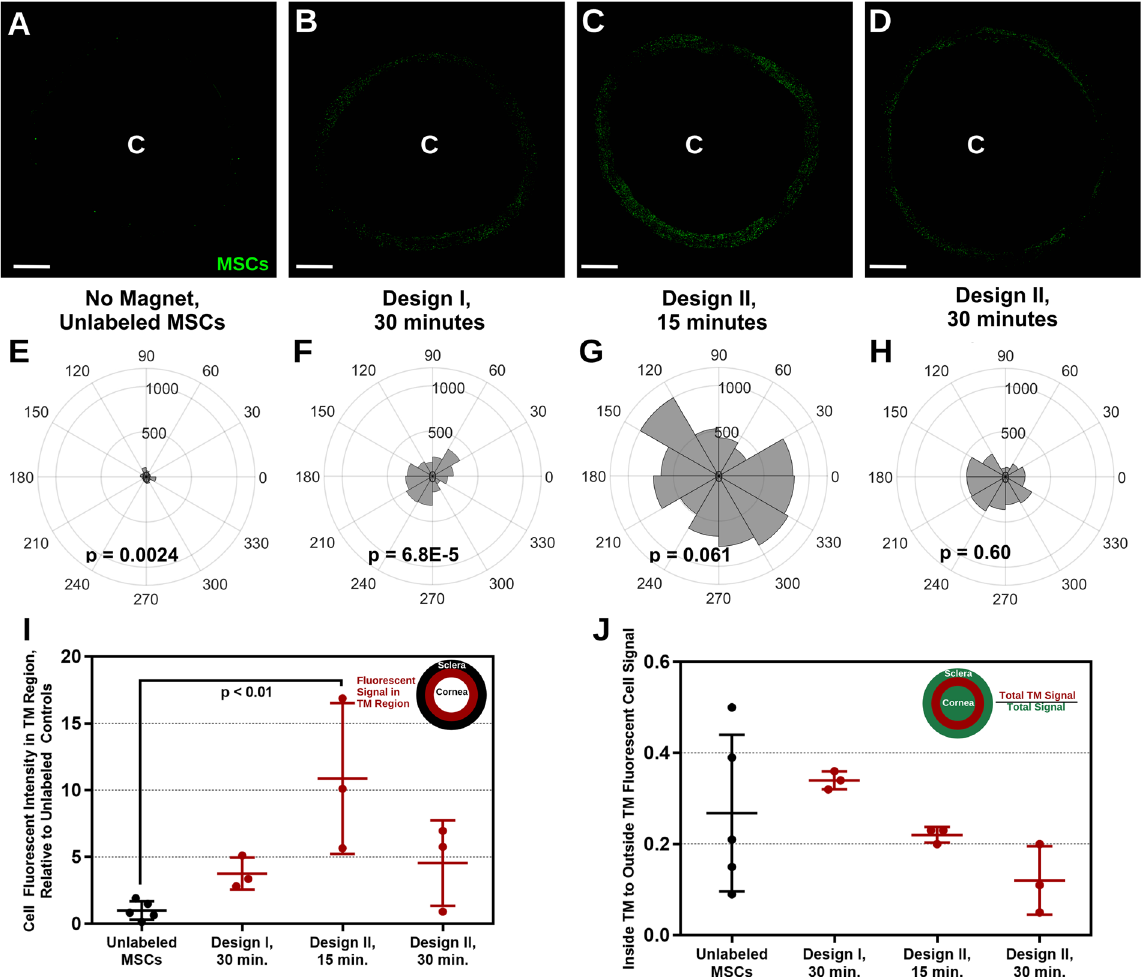
Figure 4. 360° Delivery of PBNC-MSCs Using Ring Magnets. (A–D) PBNC-MSCs were injected into eyes with two types of ring magnets placed around the circumference for different durations. Representative en face micrographs are shown. “C” denotes the approximate center of the cornea. Note that the image has been masked so that only signal from the putative TM region is shown (see Methods). Scale bars denote 2 mm. (E–H) The polar histograms illustrate the total fluorescence intensity within the TM region (plotted on the radial coordinate, in arbitrary units) for 30° sectors around the eye. P-values were calculated using Rayleigh’s test to assess uniform circumferential delivery (p < 0.05 denotes non-uniform delivery). (A,E) no magnet (n = 5 eyes), (B,F) Magnet Design I for 30 minutes (n = 3 eyes), (C,G) Magnet Design II for 15 minutes (n = 3 eyes), and (D , H) Magnet Design II for 30 minutes (n = 3 eyes) experiments are shown. (I) Quantification of cell signal in the TM relative to signal from eyes injected with unlabeled MSCs. (J) MSC delivery specificity to the TM, i.e. fluorescent signal in the TM region relative to the fluorescent signal outside the TM (i.e. anterior or posterior to the TM margins). Individual data points are shown with central bars indicating mean values and error bars denoting standard deviation. Significant differences (p < 0.05) between groups were determined by one-way ANOVA with post hoc Tukey